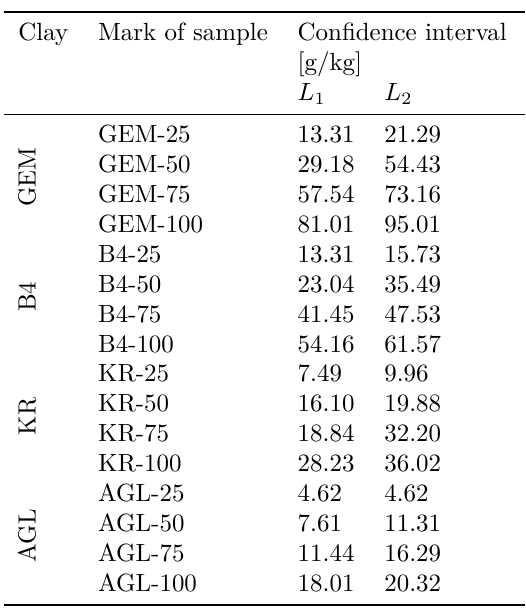
Table 5. Calculated confidence interval limits of ad- sorption for clays ( α = 0 .